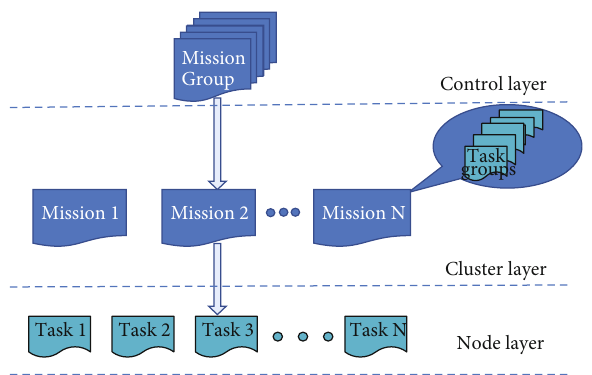
Figure 2: Mission decomposition architecture